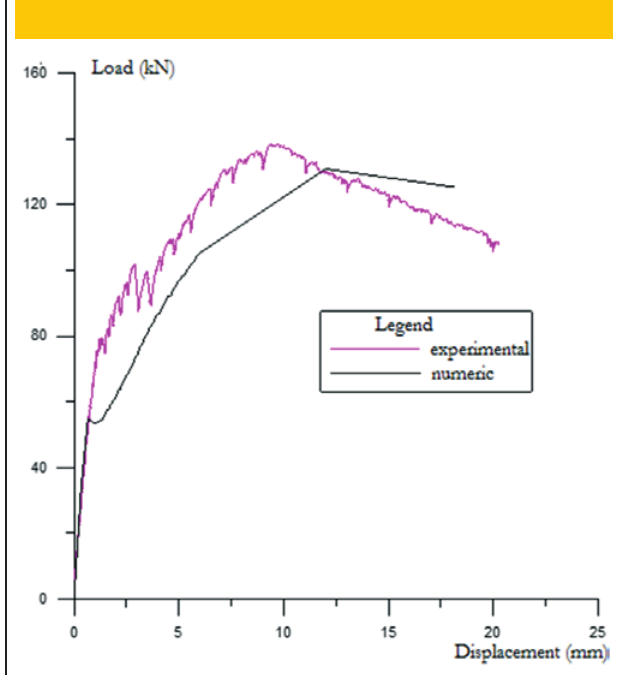
Figure 27 – Parametric identification through beam V9 with 1.25%